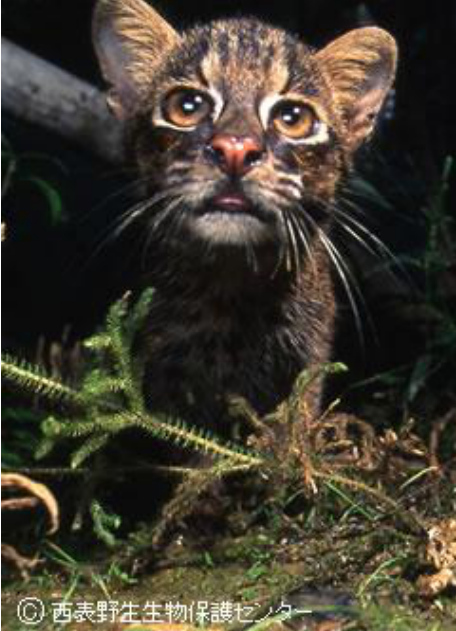
Figure 1. The Iriomote cat ( Felis iriomotensis ) has been listed as an endangered species by the International Union for the Conservation of Nature and Natural Resources. Photo by Iriomote Wildlife Conservation Center